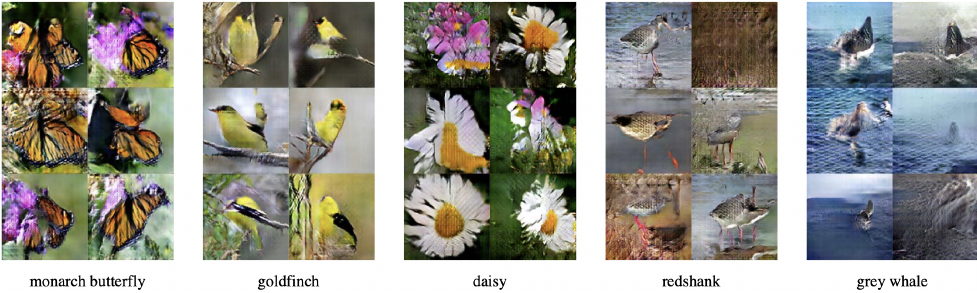
Figure 12. Images of five distinct classes generated by the AC-GAN. Nowadays, the detail in the images is far superior to the one provided by the AC-GAN. Image taken from